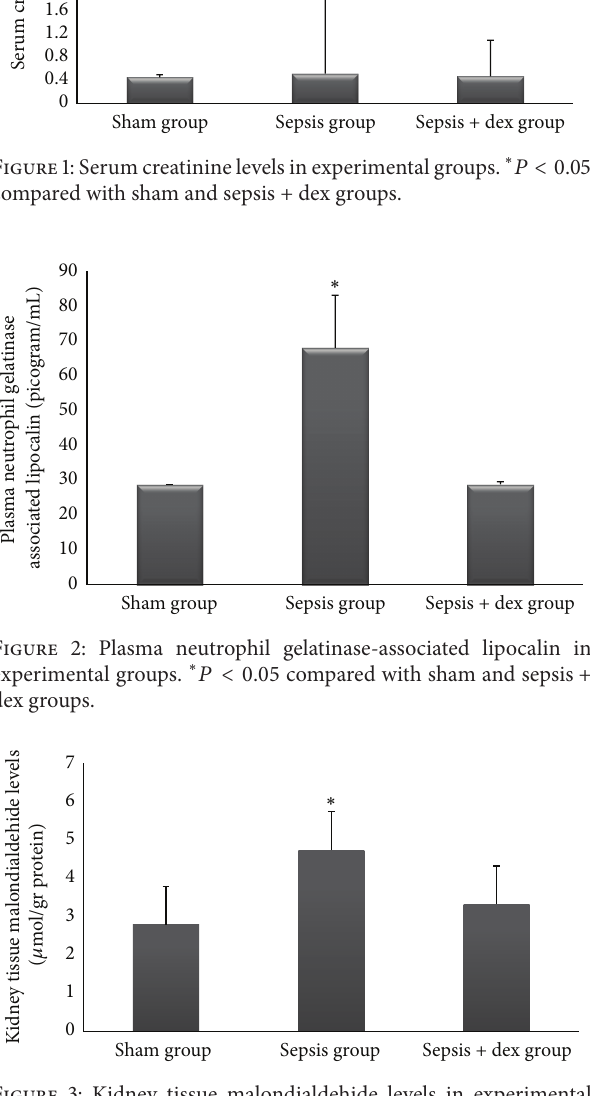
Figure 3: Kidney tissue malondialdehide levels in experimental groups. ∗ 𝑃 < 0.05 compared with sham and sepsis + dex groups.